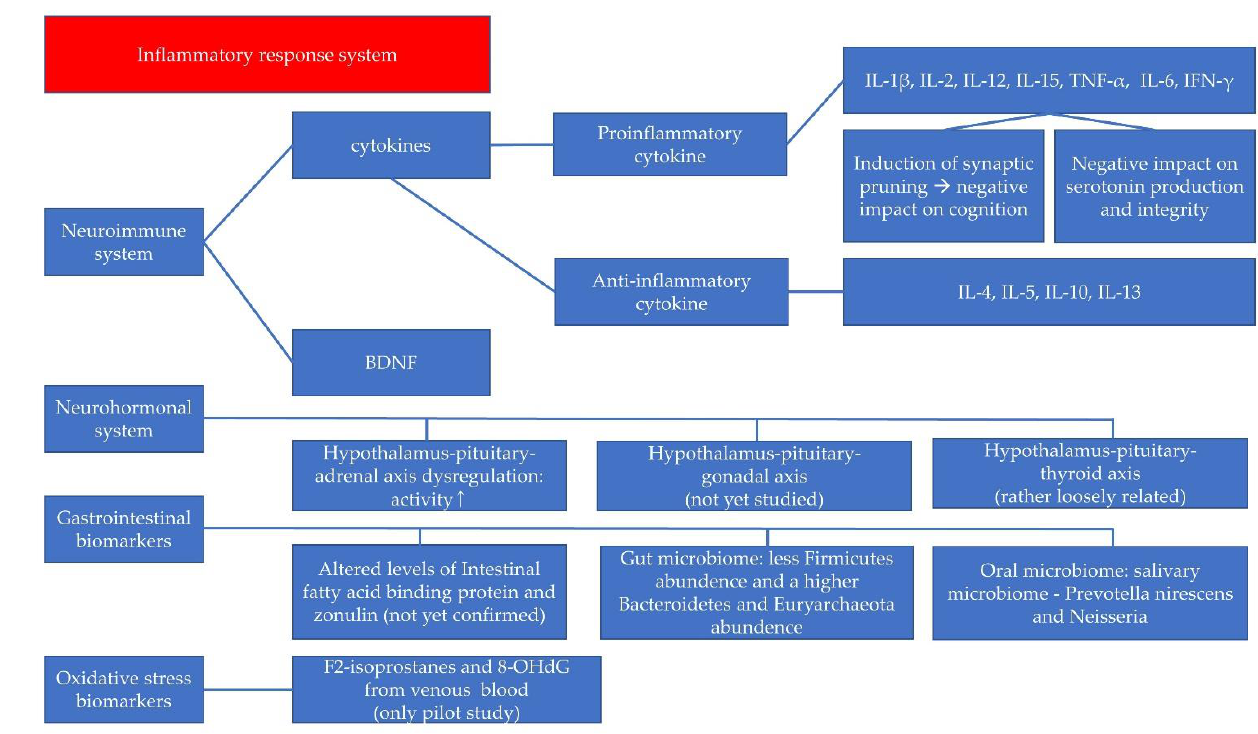
Figure 1. Summary of suggested biomarkers for childhood and adolescent depressive disorders. Pro-inflammatory cytokines induce HPA hyperactivity which is related with the inflammatory response